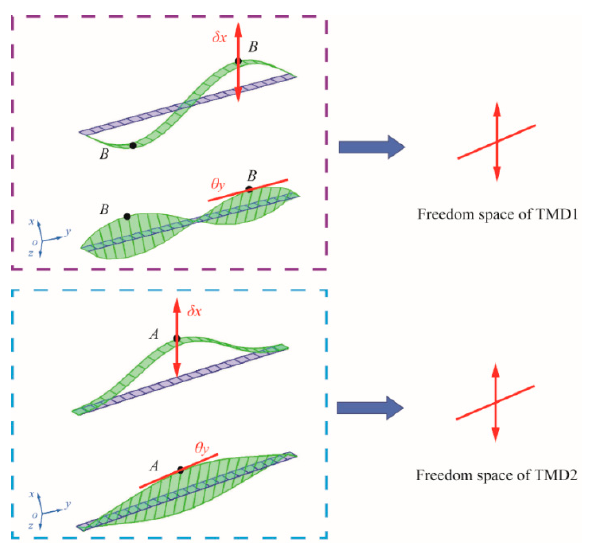
Figure 8. Shapes of the targeted modes and the corresponding optimal location of the TMD: the optimal location of the modes (2B,1T) at point A, while it is point B for modes (1B,2T); the freedom space of the TMDs.